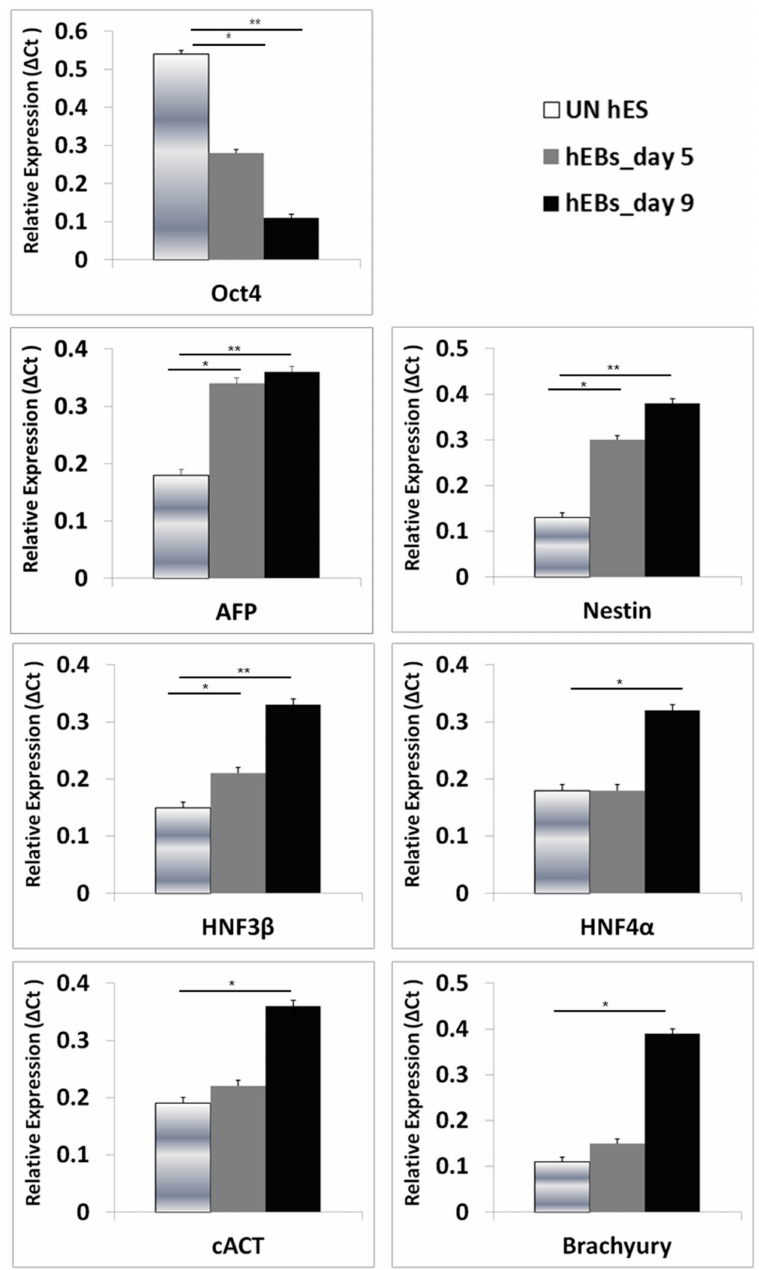
Figure 2. Expression of pluripotency and three germ layer markers on undi ff erentiated hESCs (UN hES), day 5 hEBs (hEBs-day 5), and day 9 hEBs (hEBs-day 9). Oct4 (undi ff erentiated, pluripotency marker) was expressed at the highest level on hESCs and decreased throughout the di ff erentiation stages. The expression of Nestin (ectoderm), α -fetoprotein ( AFP ), hepatocyte nuclear factor ( HNF) 3 β , HNF4 α (endoderm), and cardiac actin (cACT) , Brachyury (mesoderm) was the highest on day 9 hEBs (* p < 0.05 and ** p < 0.01,